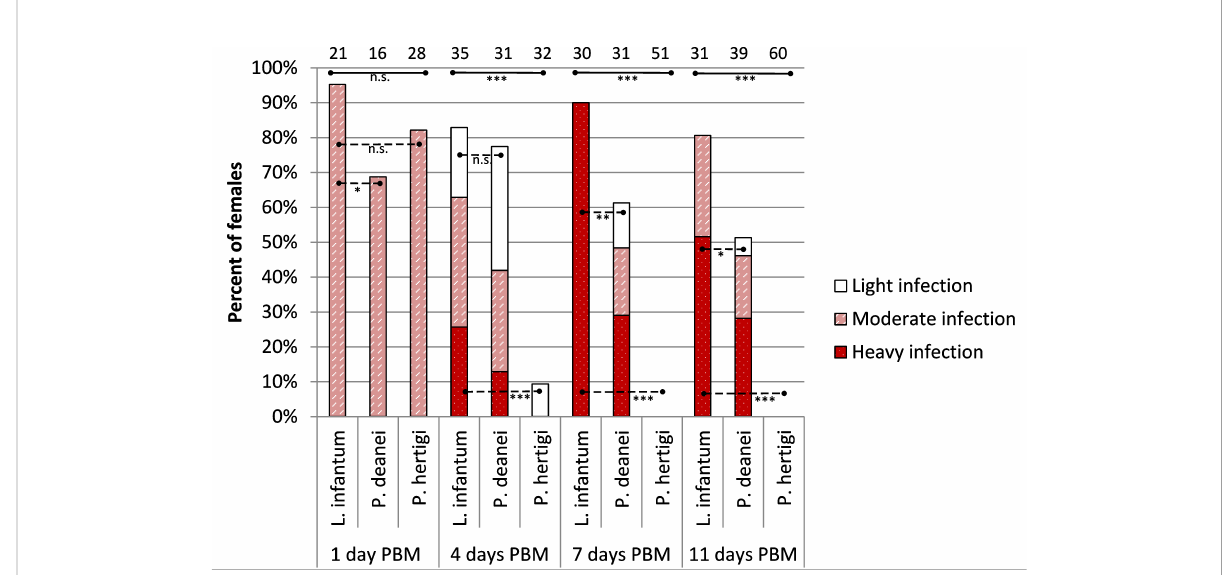
FIGURE 2 Infection rates and intensity of P. deanei , P. hertigi and L. infantum in Lutzomyia longipalpis . Numbers of dissected females are shown above the bars. Signi fi cance of between species differences in infection rates were evaluated using Chi-Square test. n.s, P > 0.05; *,P < 0.05; **P < 0.01; ***P < 0.001. Full lines, difference among all three tested species; dashed lines, difference between two interconnected